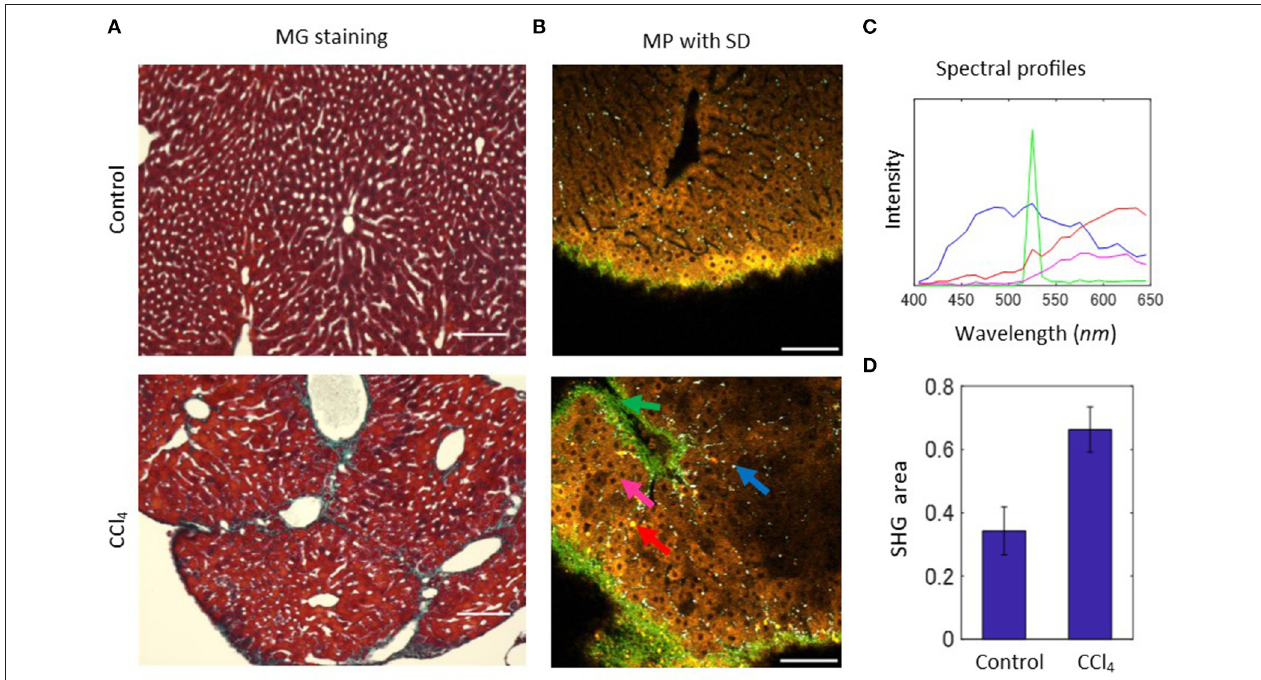
FIGURE 2 | MP excitation spectral imaging for liver tissues of the CCl 4 -induced liver fibrosis model. (A) Histological images of the MG-staining sections for liver tissues of the control and CCl 4 models. (B) MP excitation spectral images for liver tissues of the 2-weeks control and CCl 4 model. In the CCl 4 image, blue arrow indicates white-colored dot-like objects, green arrow indicates SHG, magenta arrow indicates hepatic parenchyma, and red arrow only observed in the CCl 4 image indicates cellular-sized objects that appeared in yellow or orange color. (C) Profiles of the emission spectra of the indicated arrows in the control and CCl 4 images in (A) . (D) Quantification result of the ratio of SHG signal area to the total image area. Scale bar: 100 µ m.